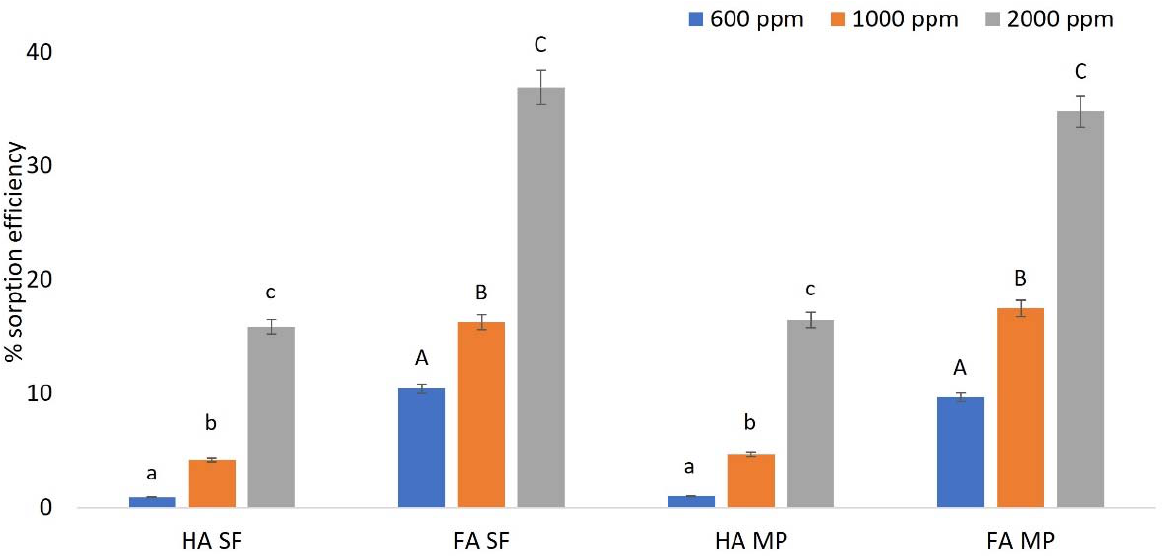
Figure 4. % Sorption efficiency of glyphosate using humic acid (HA) or fulvic acid (FA) extracted from different concentrations of lignite from South Field (SF) or Mavropigi (MP) mines; bars represent the average sorption efficiency of five replicate analyses; statistically significant differences ( p < 0.05) are depicted with small and capital letters.